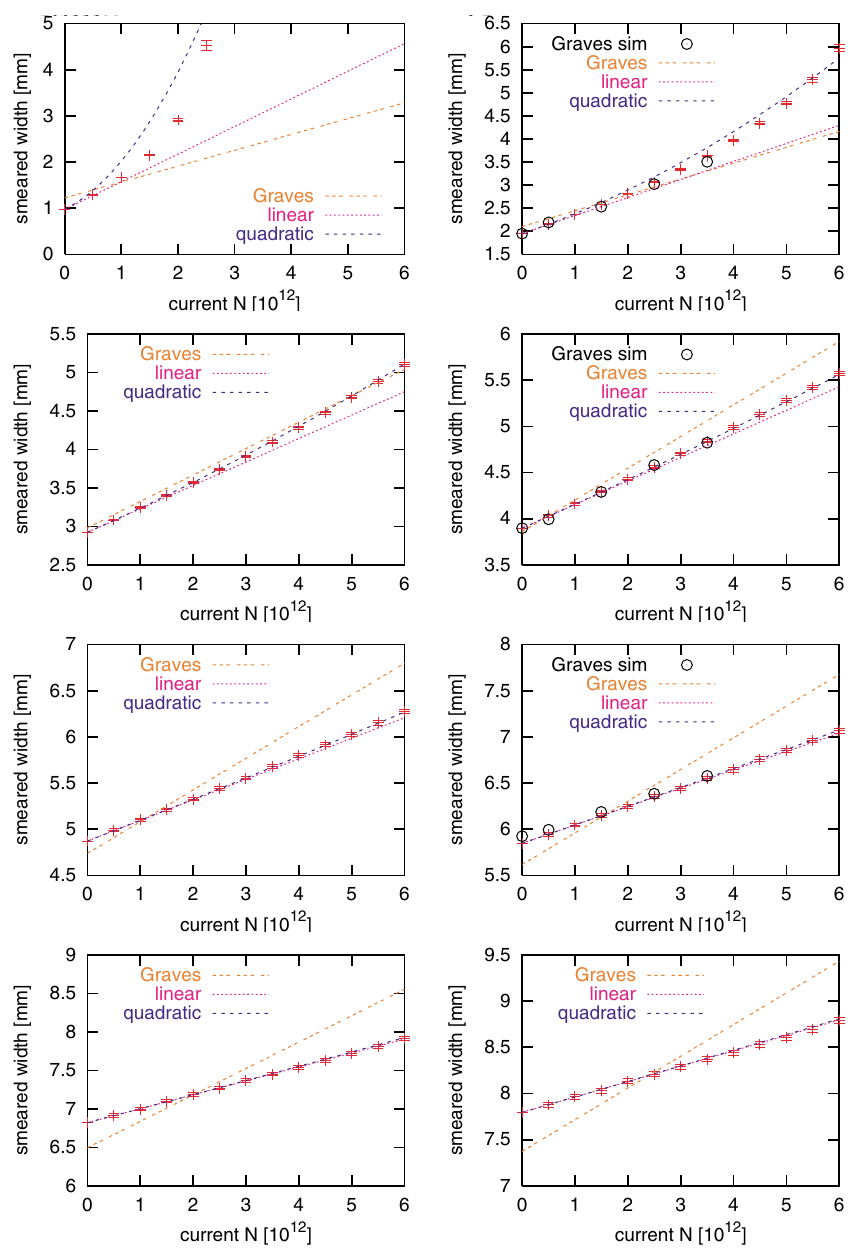
FIG. 2. (Color) Simulations and parametrizations. The crosses are the results of our OCTAVE simulation, including error bars. The circles are the results of the simulation in Graves’ thesis, for which no error bars are available. The smeared width is the width that would be observed in the IPM under the assumptions of our model, and it is plotted versus the beam current, in units of 10 12 protons , the value which corresponds to zero current. The per turn. Each one of the plots corresponds to a different initial value of (cid:1) real linear and quadratic forms used to parametrize the response of the IPM are described in the text, as is the Graves